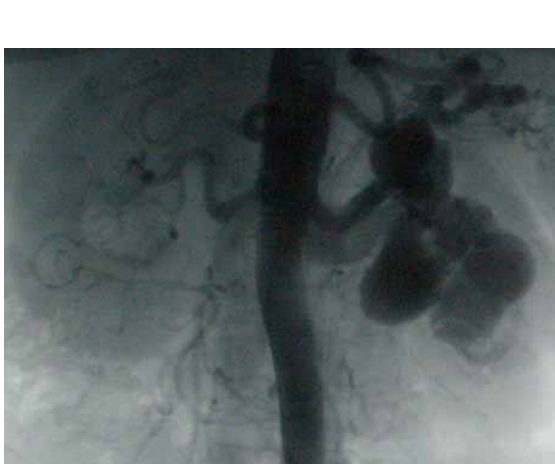
Figure 2. Color duplex ultrasonography image demonstrates an area of intense and high-flow vascular structure in the lower pole, with high velocity (165.5 cm/s) and low resistant index (0.38).